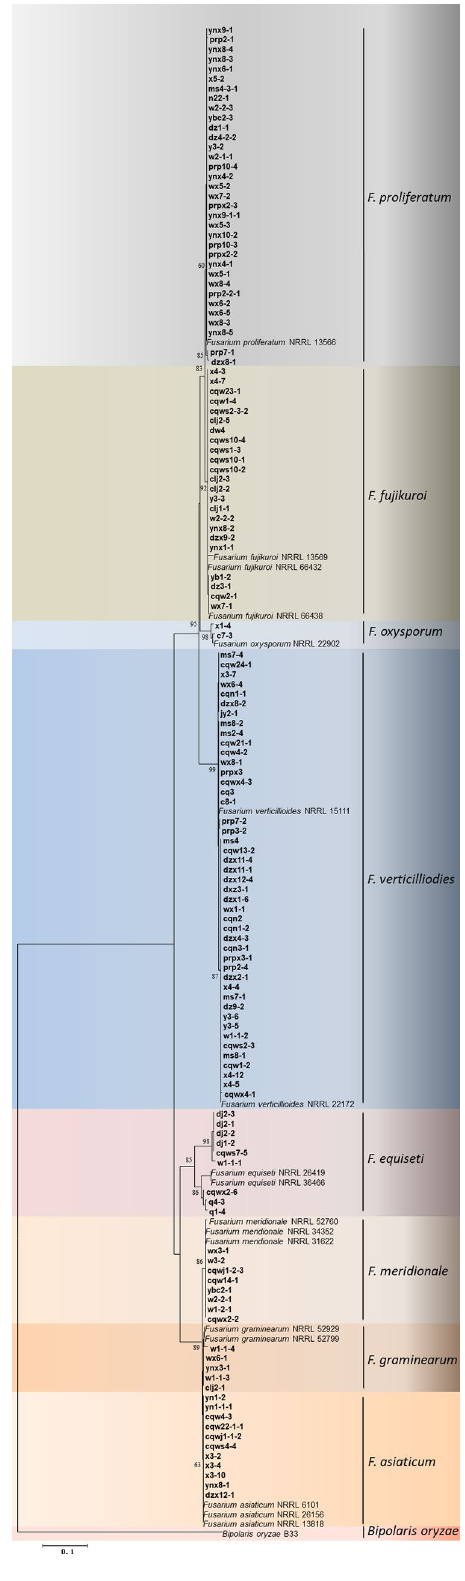
Figure 4. Phylogenetic tree of Fusarium isolates based on neighbor-joining analysis of the EF1-α gene; bootstrap values are from a bootstrap test of 1000 replicates. Isolates for which type strains were included in the study are indicated in